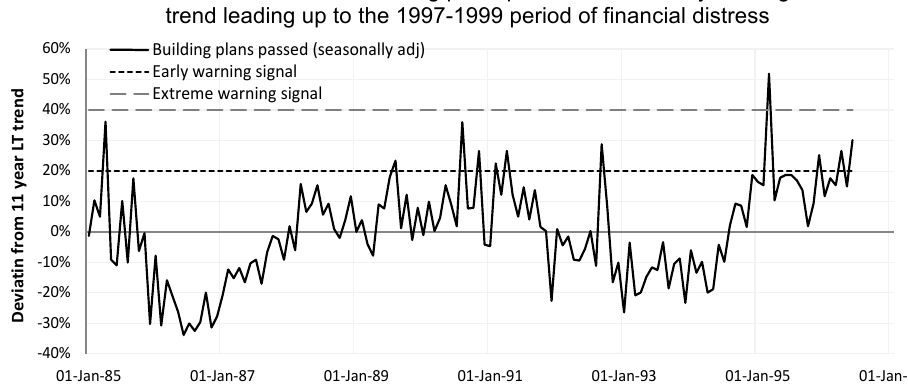
Deviation of the number of building plans passed from its 11-year long-term trend leading up to the 1997-1999 period of financial